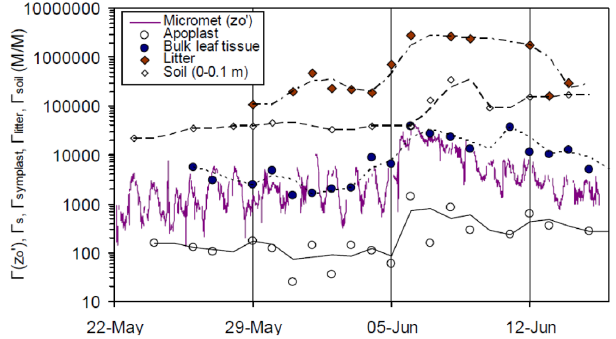
Fig. 3. Time course of estimated 0 values (ratio of [NH + in different compartments of a mixed grassland ecosystem (from Sutton et al., 2009b). The grass was cut on 29 May and lifted for silage on 31 May. Fertilizer (100kg Nha − 1 as calcium ammonium nitrate) was applied on 5